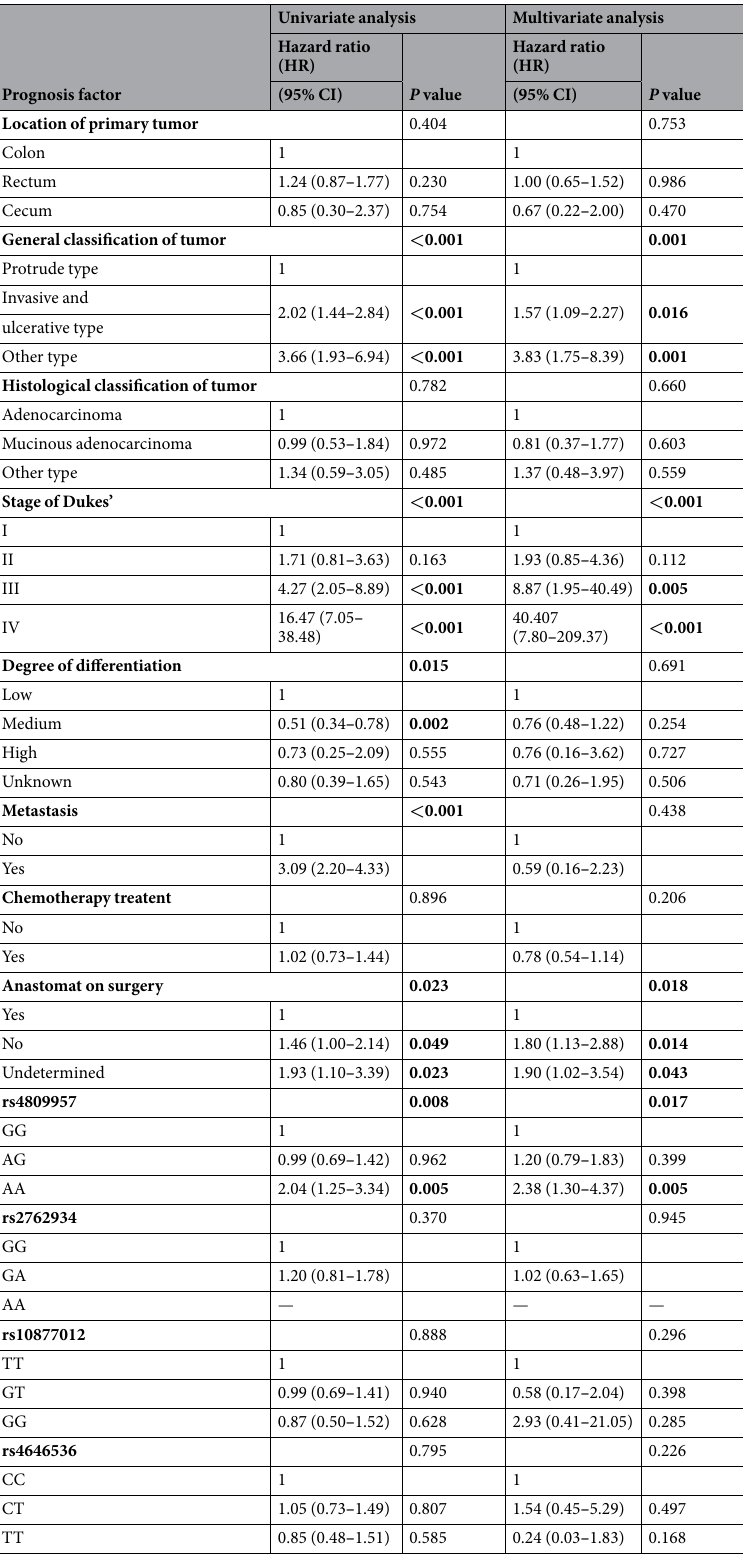
Table 6. Associations between clinical characteristics, polymorphisms in CYP24A1 , CYP27B1 and the prognosis of CRC. Hazard ratio (HR), adjusted by age and